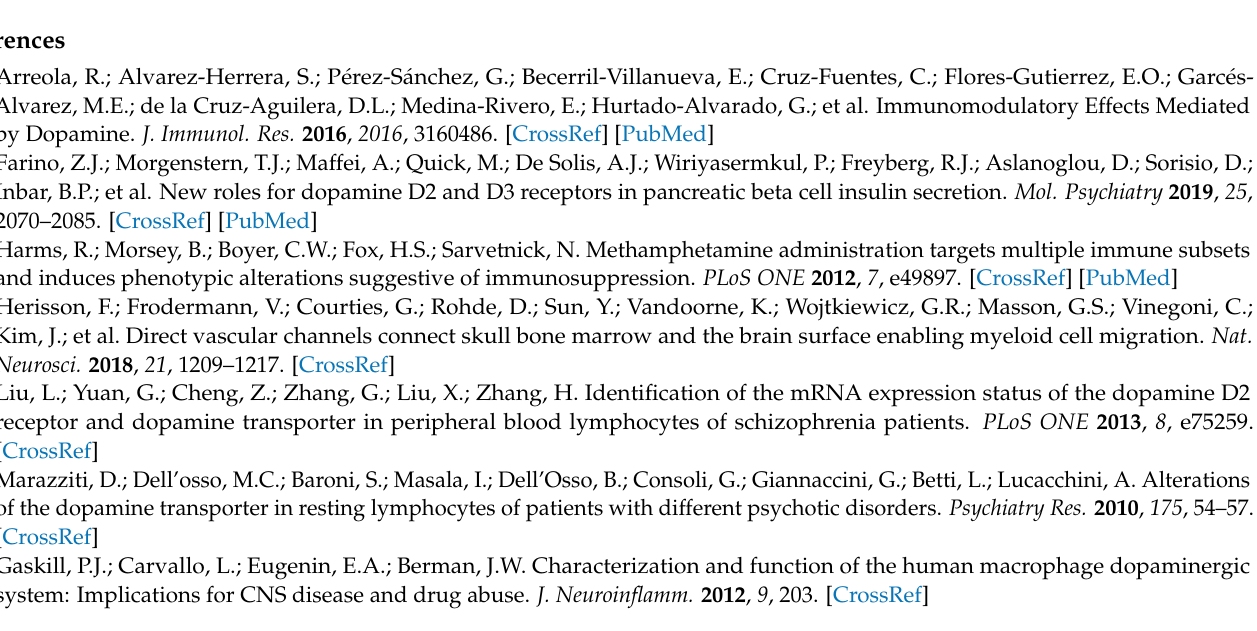
Figure S3: Fluorescence minus one analysis strategy for analysis of peritoneal